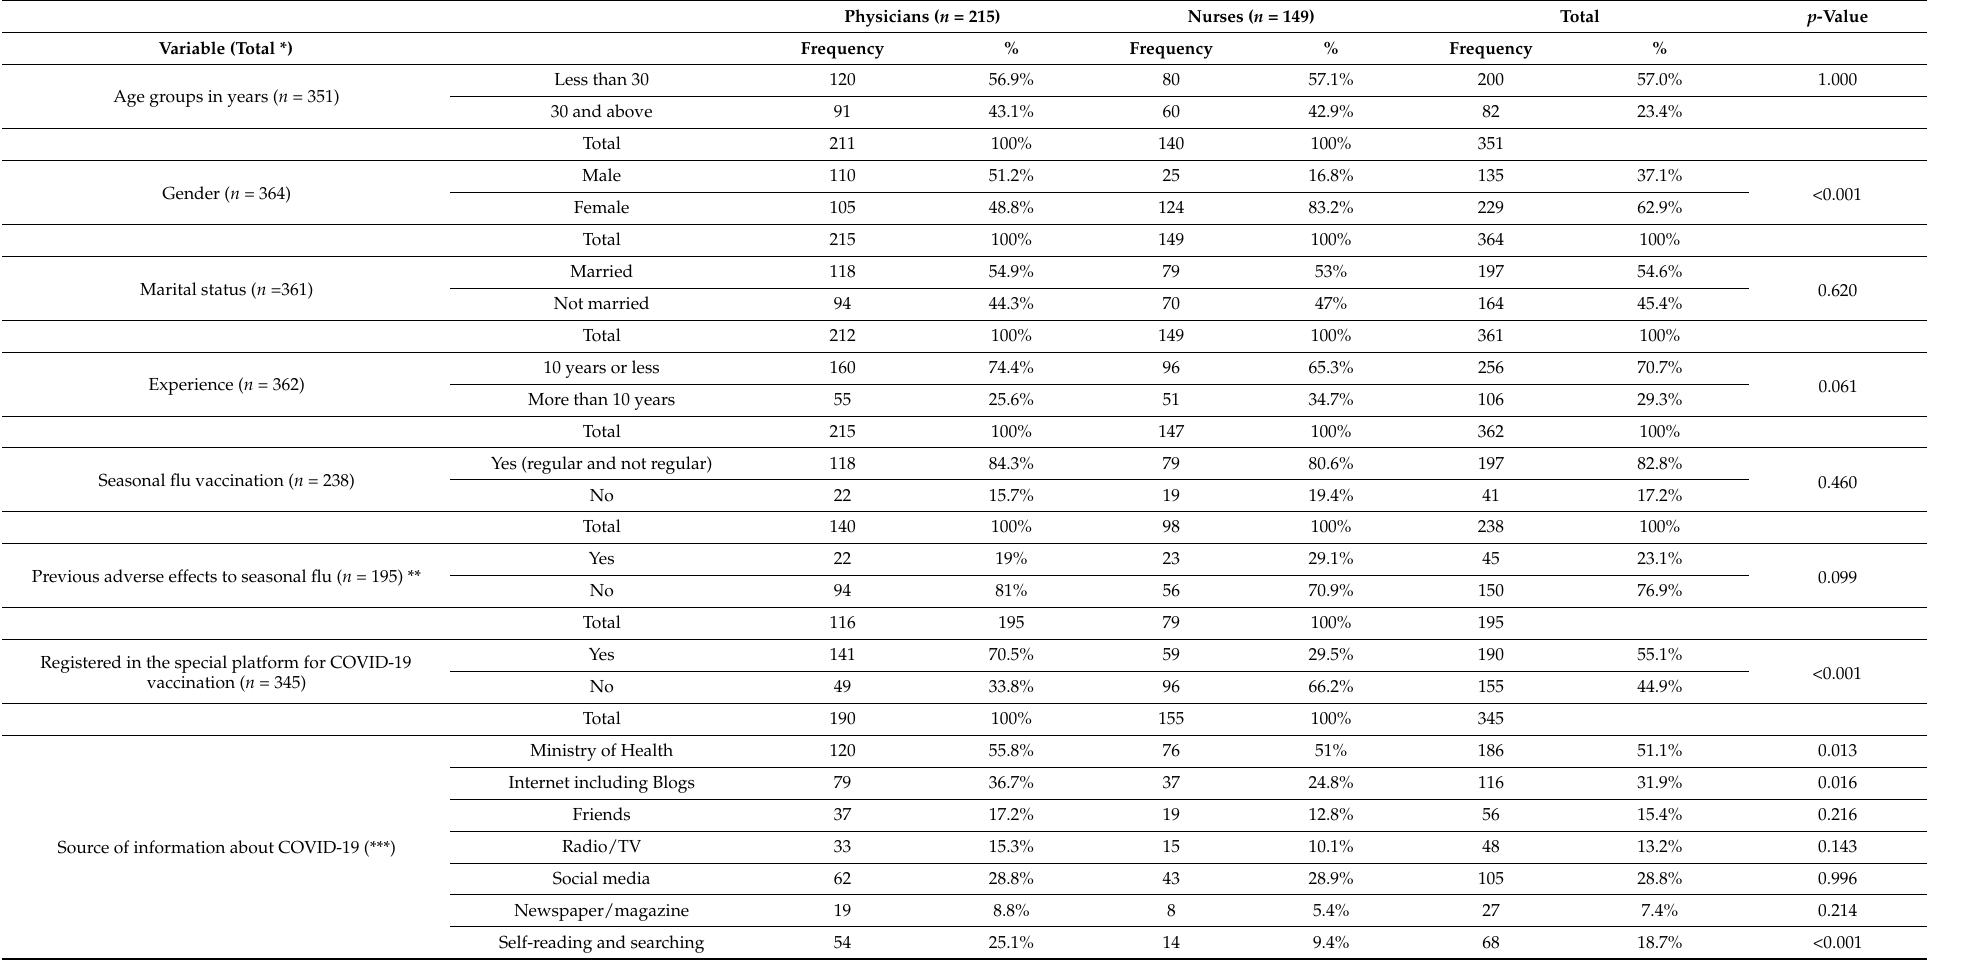
Table 1. Demographic characteristics of healthcare workers stratified by work